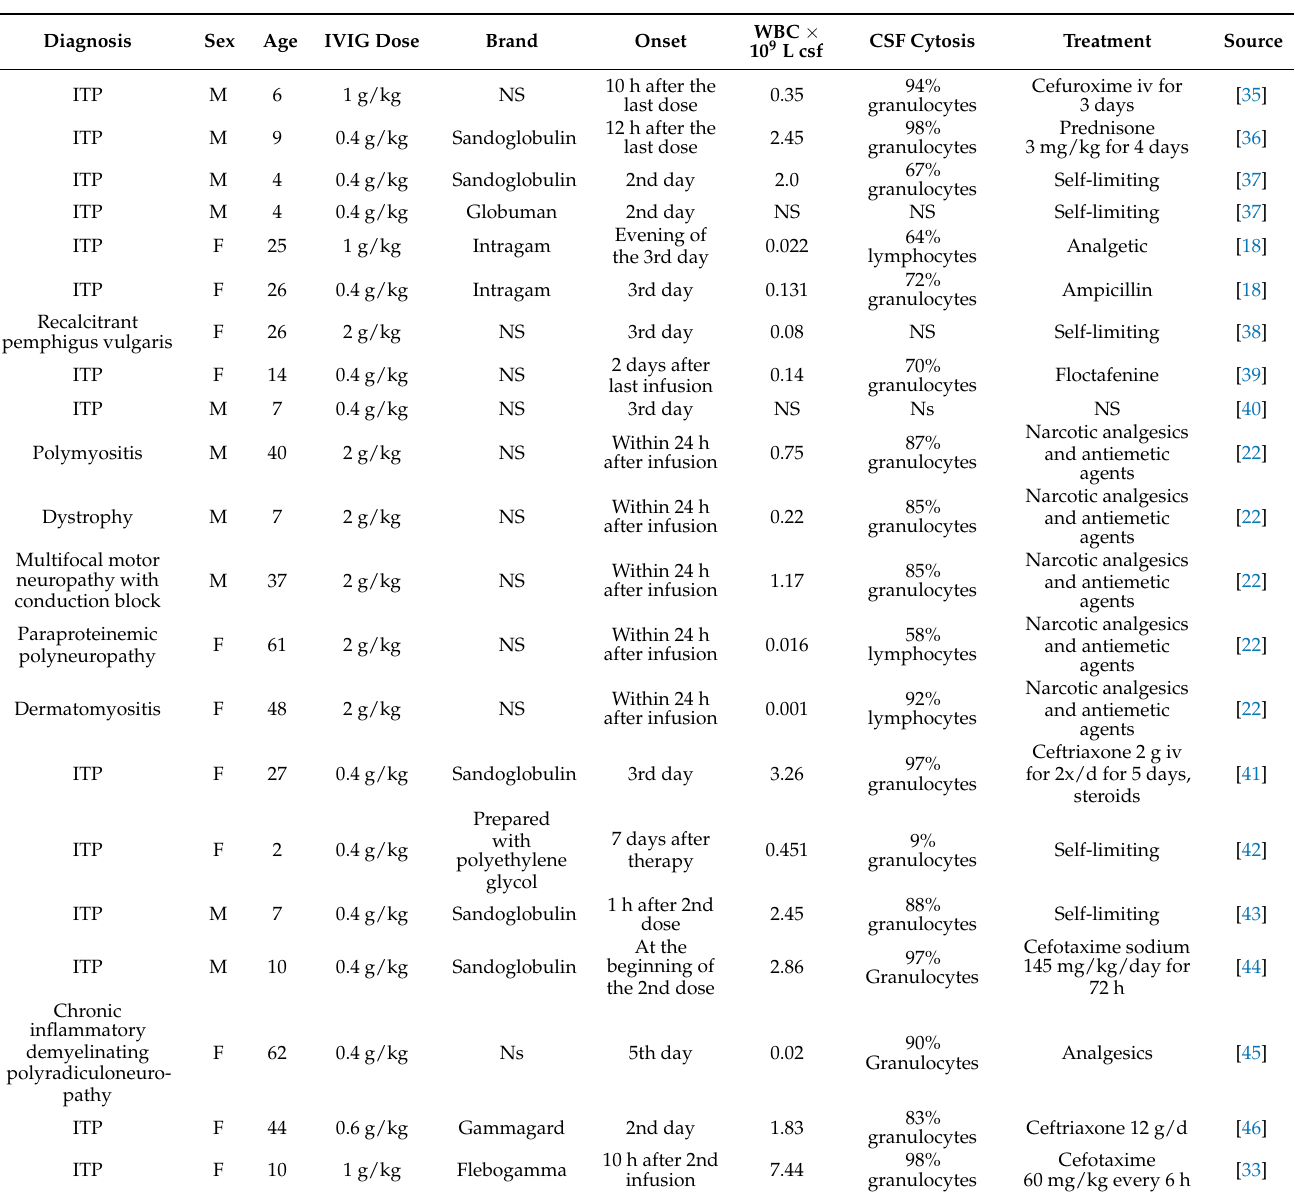
Table 1. Cases of documented IVIG-related aseptic meningitis in the years